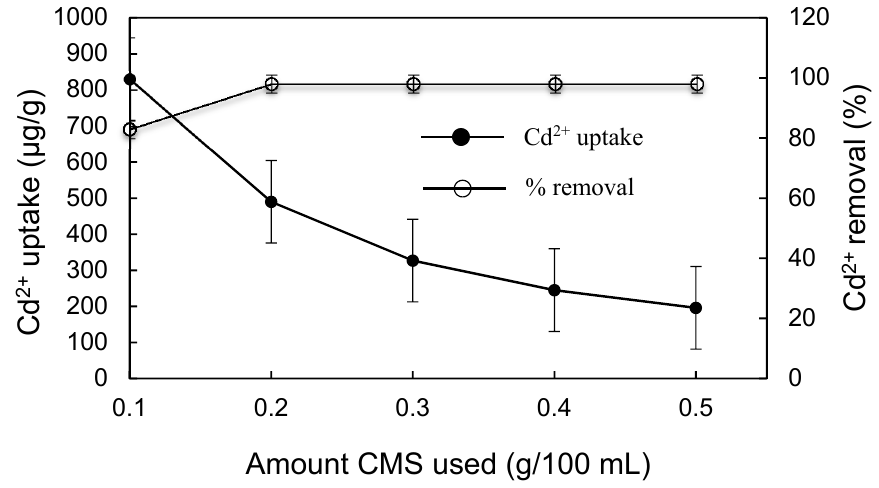
Figure 9. Effect of dosage of CMS on Cd 2+ uptake and removal.